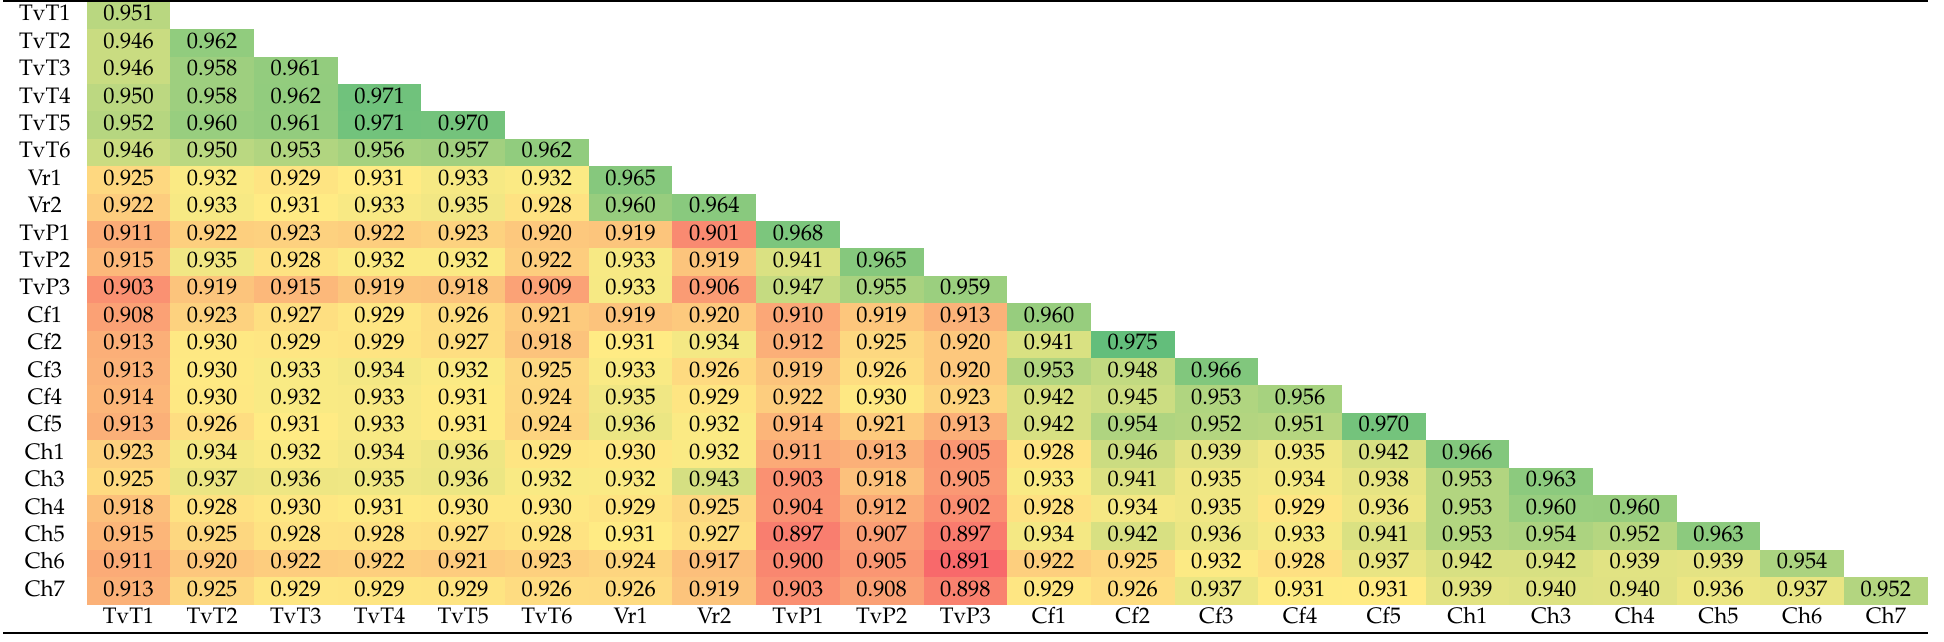
Table 3. Average Dice’s genetic similarity (GS) matrix calculated within and between the radicchio populations analyzed in this study. Colors range from green (highest values) through yellow (mid values) to red (lowest